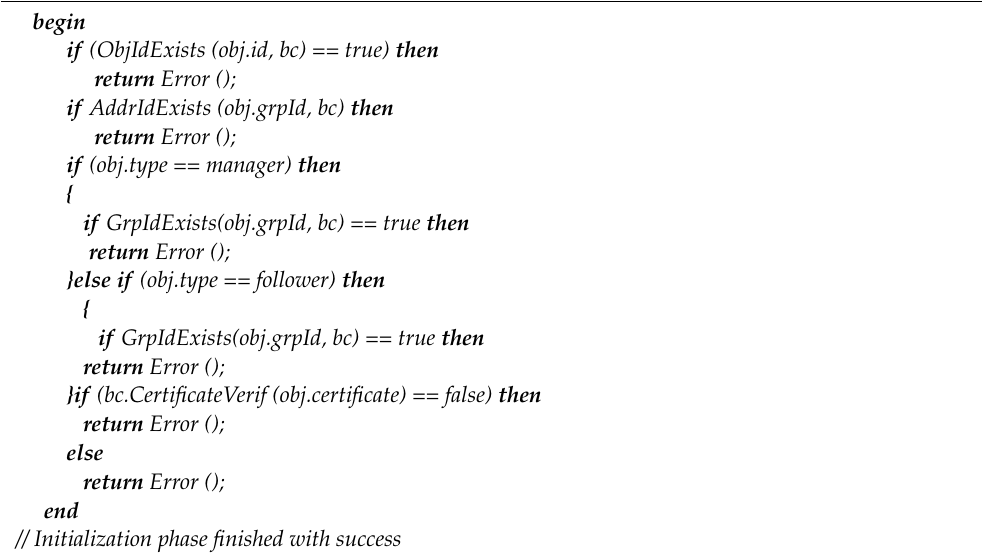
Algorithm 1: Smart Contract Initialization Phase